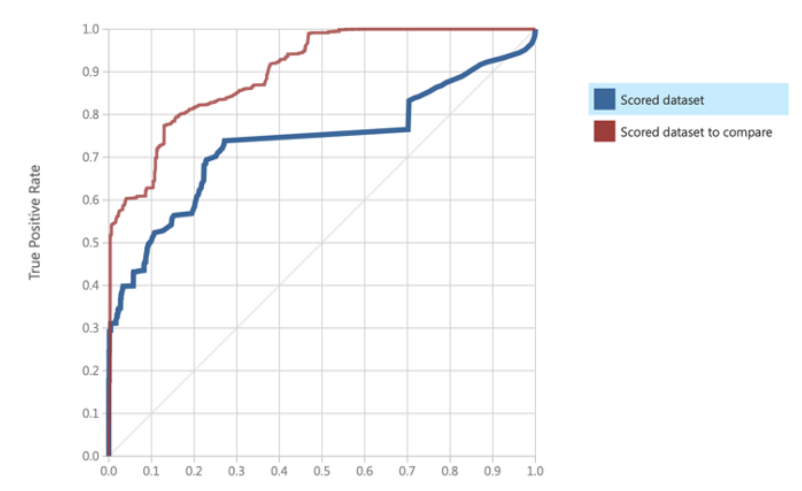
Figure 8. Semi-supervised models